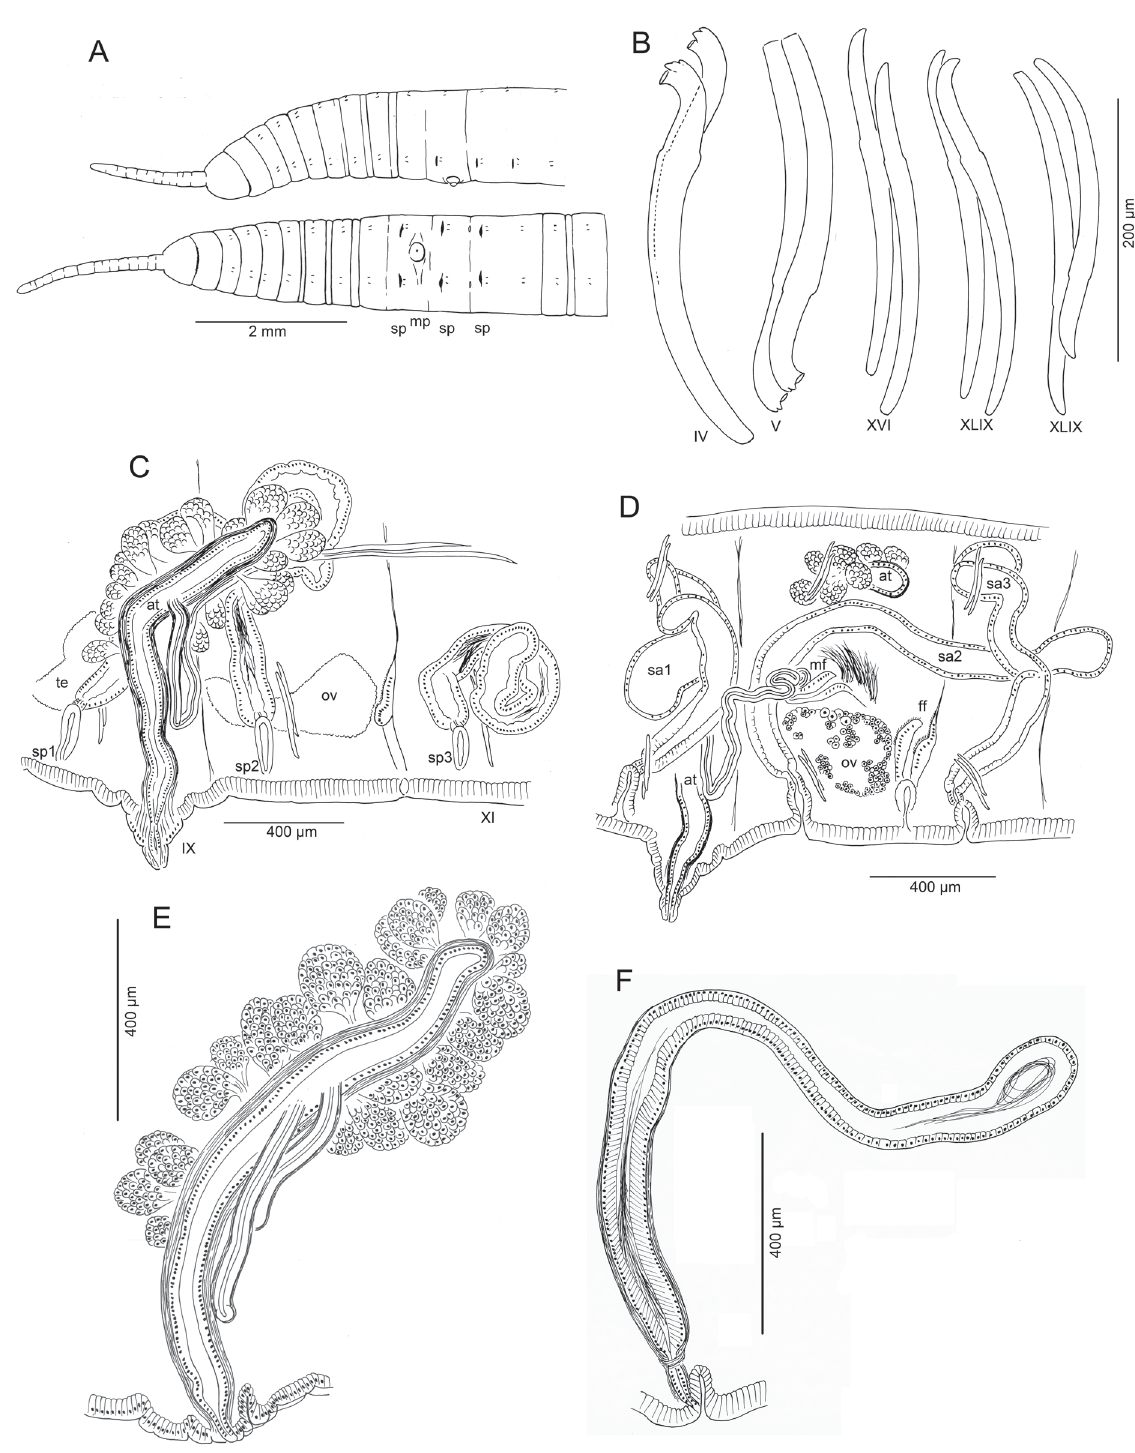
Fig. 4. Kincaidiana smithi Fend & Rodriguez sp. nov., from the type locality, except for C , from seep by South Fork Smith River, CA. A . Complete worm, lateral and ventral views, showing location of reproductive pores. B . Representative chaetae: Roman numerals indicate segment number; dorsal chaetae with tips upward, ventrals with tips down. C . Reproductive organs in IX-XI. D . Reproductive organs in IX-XI, from a sagittal section (middle portion of atrium missing). E . An atrium, joined by both vasa deferentia. F . A